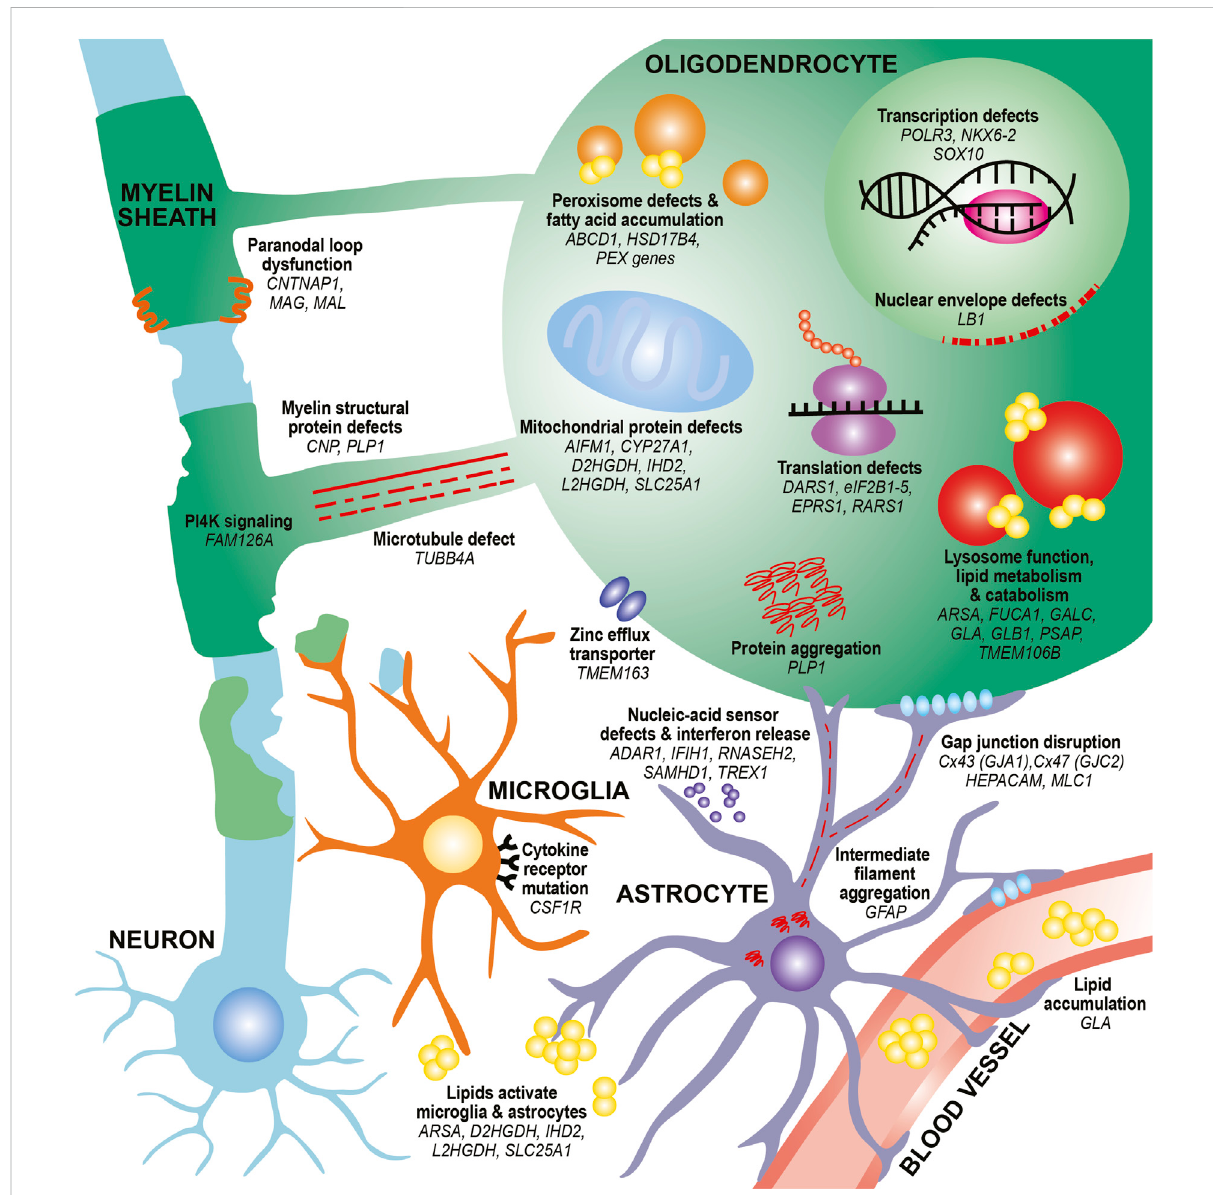
FIGURE 1 Diverse mechanisms and cell types contribute to hypomyelination in leukodystrophies. In oligodendrocytes, mutations in myelin structural proteins ( CNP , PLP1 ) can lead to thinner myelin sheaths and paranodal loop malformation ( CNTNAP1 , MAG , MAL ). PLP mutations can also lead to aberrant protein aggregation. Other mutations can affect the function of organelles that participate in lipid metabolism and catabolism, such as peroxisomes ( ABCD1 , HSD17B4 , PEX family genes) and lysosomes ( ARSA , FUCA1 , GALC , GLA , GLB1 , PSAP ). These defects can also lead to toxic lipid accumulation that builds up in the bloodstream ( GLA ) or activate astrocytes and microglia ( ARSA ). Finally, mutations affecting transcription factors ( NKX6-2 , SOX10 ), transcriptional machinery ( POLR3 genes) and translation machinery ( DARS1 , eIF2B genes, EPRS1 , RARS1 ) cause impair differentiation of oligodendrocytes and reduce production of myelin proteins. Defects in microtubules that project toward and within the myelin sheath ( TUBB4A ) as well as in PI4K signaling pathways that contribute to wrapping ( FAM126A ) can affect myelin sheath growth. Mutations in mitochondrial genes can lead to lipid processing defects ( CYP27A1 ), aberrant activation of apoptotic pathways ( AIFM1 ), and metabolic issues ( D2HGDH , IHD2 , L2HGDH , SLC25A1 ). Other pathways, such as nuclear envelope integrity ( LB1 ) and zinc ef fl ux ( TMEM163 ) can also affect oligodendrocyte health. In astrocytes, intermediate fi lament protein mutations ( GFAP ) can lead to its aggregation and formation of Rosenthal fi bers. Mutations affecting gap junctions can disrupt cell junctions between astrocytes and oligodendrocytes ( GJA1 , GJC2 ) and between astrocytes and vasculature( HEPACAM / GLIALCAM , MLC1 ).Mutationsaffectingnucleic-acidsensors( ADAR1 , IFIH1 , RNASEH2 genes, SAMHD1 , TREX1 )canactivatean immuneresponseandreleaseofinterferonsfromastrocytes.Inmicroglia,mutationsincytokinereceptors( CSF1R )canaffectmicroglialproliferation, differentiation, and activation. Finally, mutations affecting lipid processing ( ARSA , D2HGDH , IHD2 , L2HGDH , SLC25A1 ) can lead to aberrant lipid accumulation, which can activate microglia and